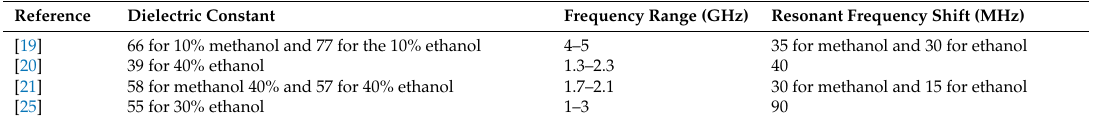
Table 1. Comparison of sensitivity between our proposed structure and other in